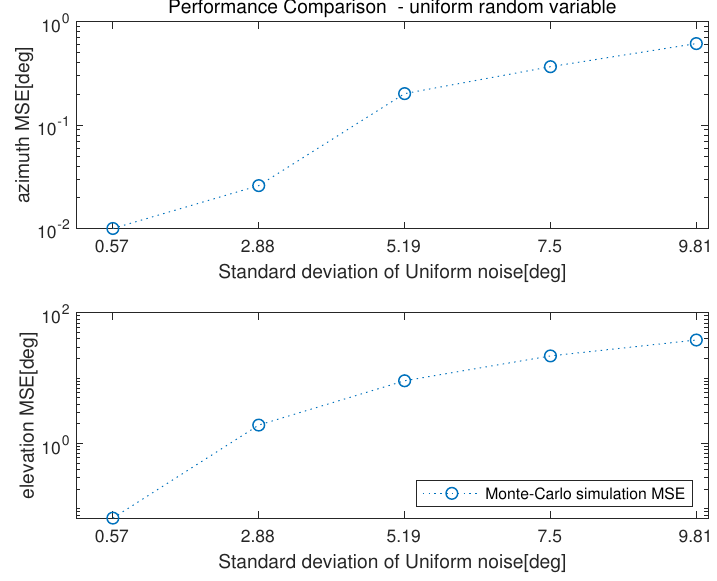
Figure 11. Performance for uniformly − distributed phase measurement error with θ ( 0 ) = 120 ◦ and ψ ( 0 ) = 15 ◦ . This figure shows the MSEs of azimuth and elevation with respect to phase error at a signal with low incident elevation by monte-carlo simulation(rectangular planar array).